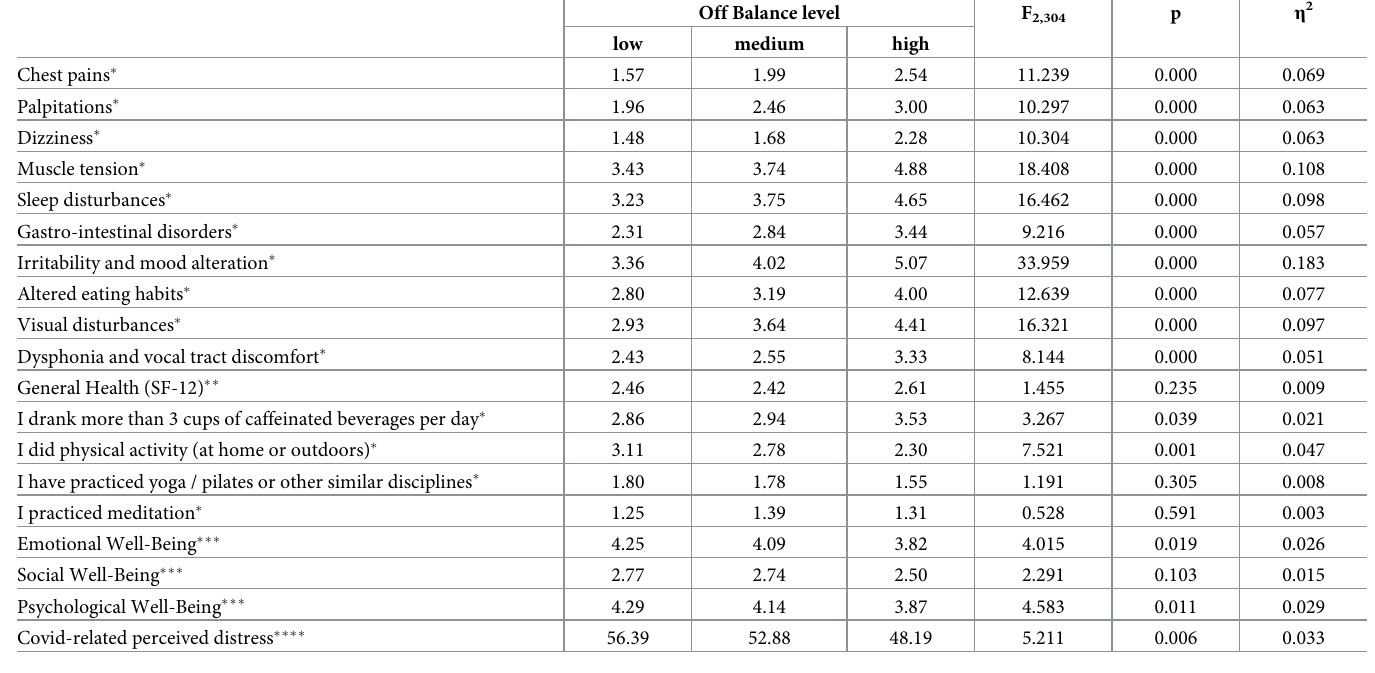
Table 9. Results of Anova–Off balance fatigue levels and